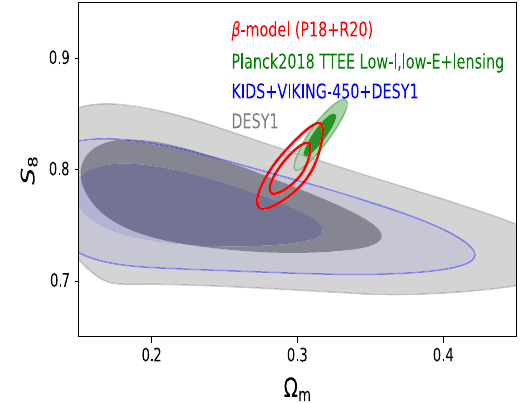
Fig. 4 The two-dimensional contour plots at 68 . 4% and 95 . 7% C.L. in the plane ( S 8 − Ω m ). Red, green and blue colours indicate the β -model for P18+R20 joint data, Planck 2018 high- l temperature TTTEEE+low- l +low-E+lensing data and KIDS+VIKING-450 in combination with DESY1 data, respectively. The grey colour indicates DESY1 data. (For interpretation of the references to colour in this figure legend, the reader is referred to the web version of this